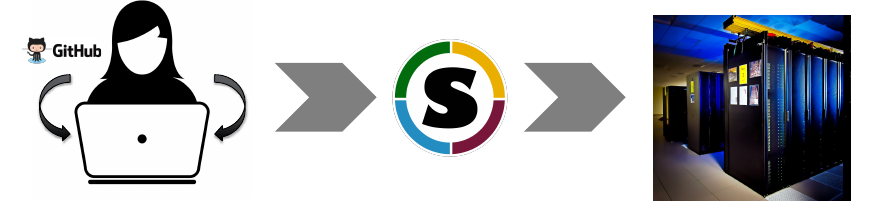
Figure 2. Project 8 development to production